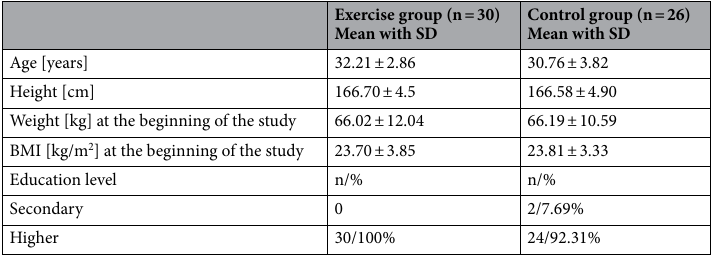
Table 1. Characteristics of women participating in the study.